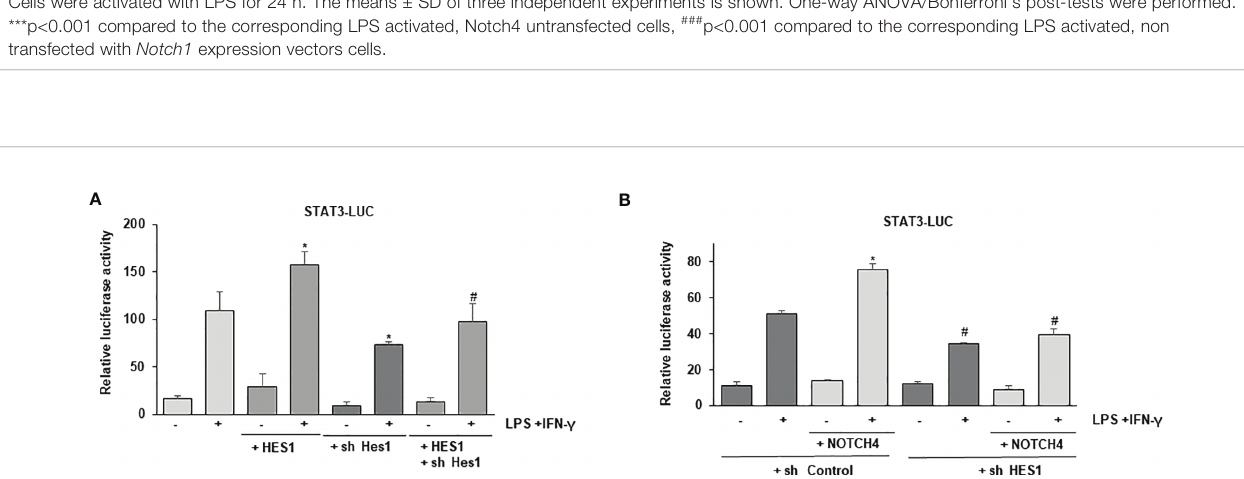
FIGURE 6 | Effect of NOTCH4 expression on NOTCH receptor processing and signaling. (A) (Upper panel) Western blot analysis of furin and ADAM10 expression; (lower panel) furin mRNA analysis by RT-PCR in Raw 264.7 cells transiently transfected with a Notch4 expression vector or the corresponding empty vector, activated with LPS (100 ng/ml) and/or IFN- g (10 U/ml) for different times. b -tubulin expression was used as a loading reference in Western blots. The image is representative of three independent experiments. RNA expression was referred to that of the P0 housekeeping genes used as a control. Quantitation of three different experiments is shown. One-way ANOVA/Bonferroni ’ s post-tests were performed. *p<0.05 compared to the corresponding control treated cells. (B) Analysis by Western blot (upper panel) and qRT-PCR (lower panel) of Notch1 gene expression in Raw 264.7 cells transiently transfected with a Notch4 expression vector or the corresponding empty vector, activated with LPS and IFN- g for different times. b -tubulin expression was used as a loading reference in Western blot. The image is representative of three independent experiments. RNA expression was referred to that of the P0 gene. Quantitation of three different experiments is shown. One-way ANOVA/Bonferroni ’ s post-tests were performed. *p<0.05 compared to the corresponding control treated cells. (C) Effect of NOTCH4 expression on NOTCH1 transcriptional activity. Raw 264.7 cells were transfected with a CBF-1 luciferase reporter plasmid in the presence of a Notch4 expression vector or the corresponding empty vector, with a full-length Notch1 (Notch1) or Notch1 intracellular domain (NIC1) expression vectors. Cells were activated with LPS for 24 h. The means ± SD of three independent experiments is shown. One-way ANOVA/Bonferroni ’ s post-tests were performed.